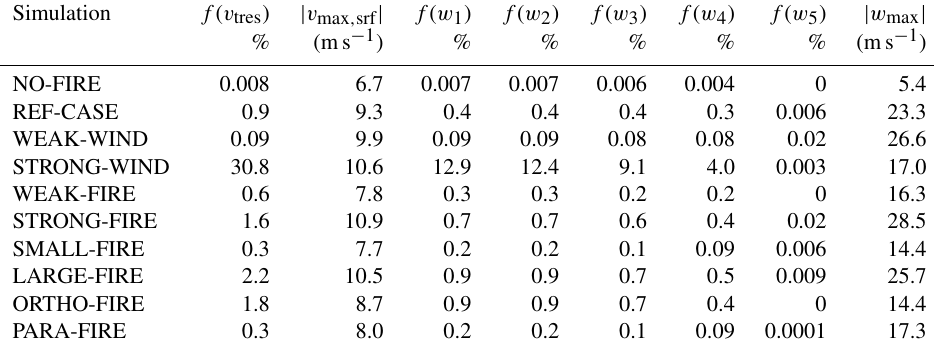
Table 3. Relative fraction of the exceedance of a horizontal wind velocity ( v tres ) of 6ms − 1 and relative fraction of a simultaneous exceedance of different vertical velocities of w 1 > 0 . 00014ms − 1 , w 2 > 0 . 009ms − 1 , w 3 > 0 . 08ms − 1 , w 4 > 0 . 27ms − 1 , and w 5 > 5 . 1ms − 1 , each within the lowest model level at z = 5m. The values concern the model domain of 2 × 1 . 2km 2 shown in Figs. 9–11. Additionally, the peak values of the horizontal near-surface wind velocity ( v max , srf ) and the total updraft velocity ( w max ) are provided.